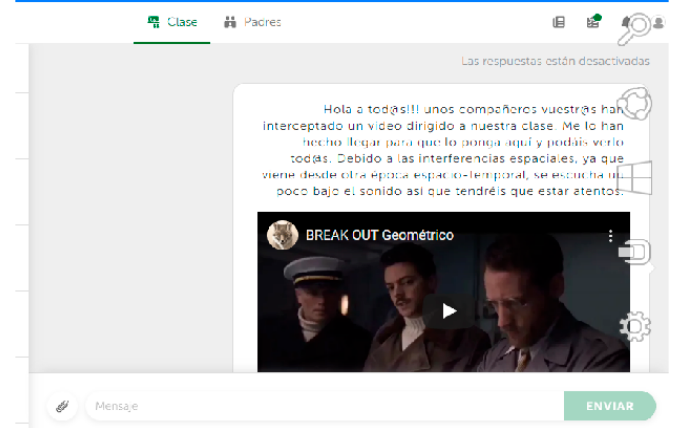
Figure 19. Winning video to kick off the Breakout EDU is showed in Classcraft’s chat.